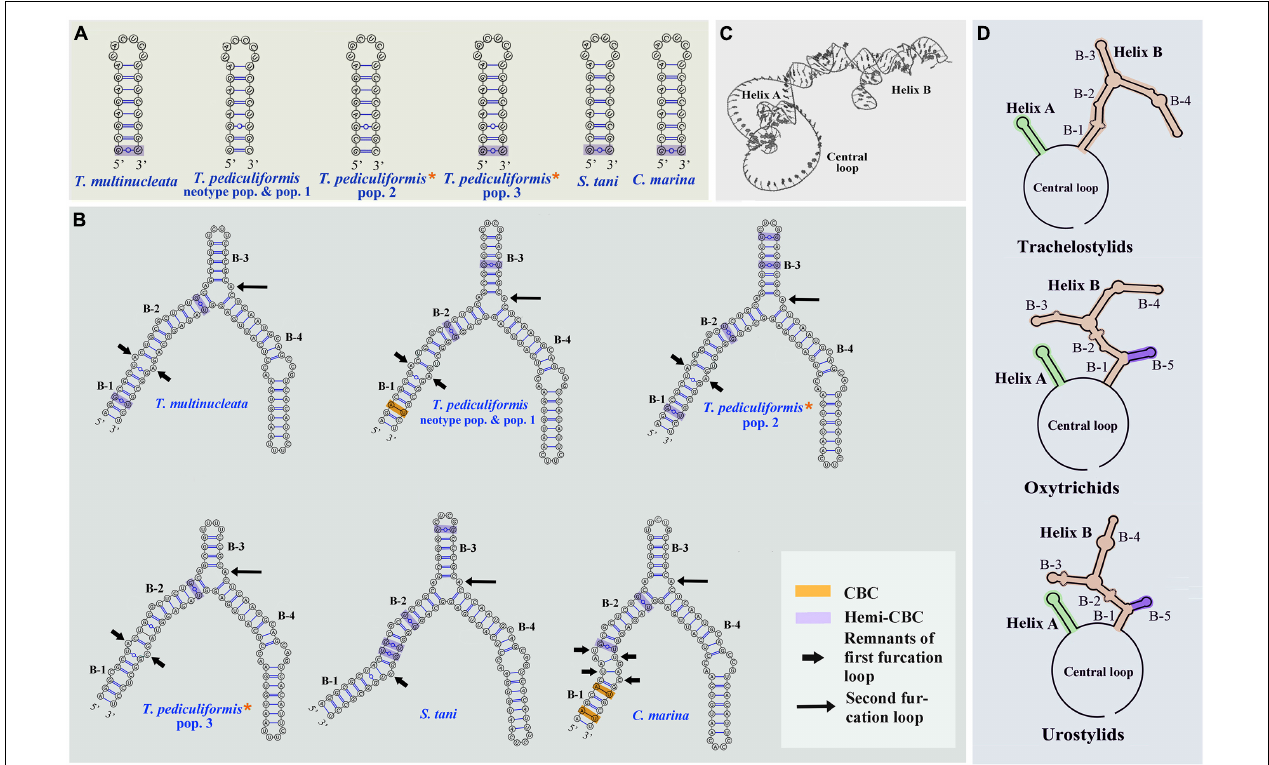
FIGURE 11 | Putative models of ITS2 molecule. (A,B) Secondary structure of helix A and B of five trachelostylids and Caudikeronopsis marina . (C) Tertiary structure model proposed for Trachelostyla multinucleata spec. nov. (D) Schematic diagrams of the ITS2 secondary structure of trachelostylids, oxytrichids, and urostylids. Trachelostyla pediculiformis pop. 2 and 3 marked by red asterisks were very likely misidentified by Huang et al.